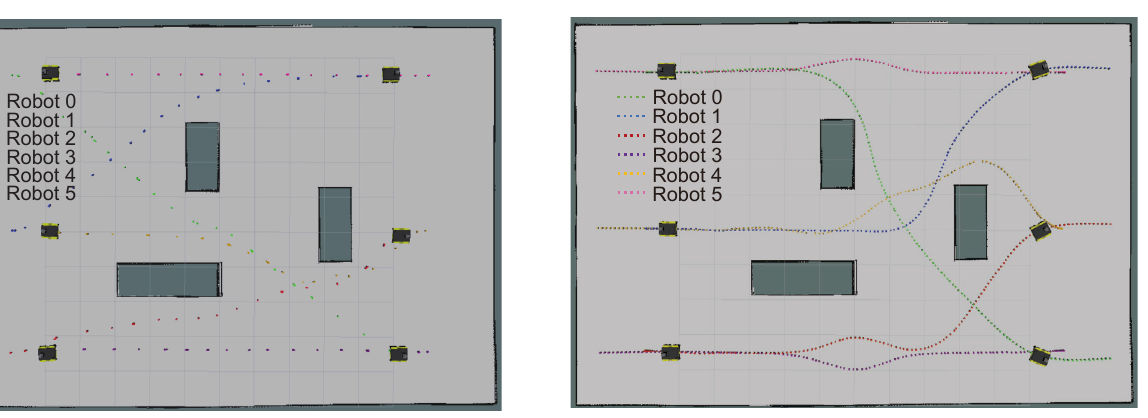
Fig. 13 Planned robot trajectories obtained using the D- MPC method.